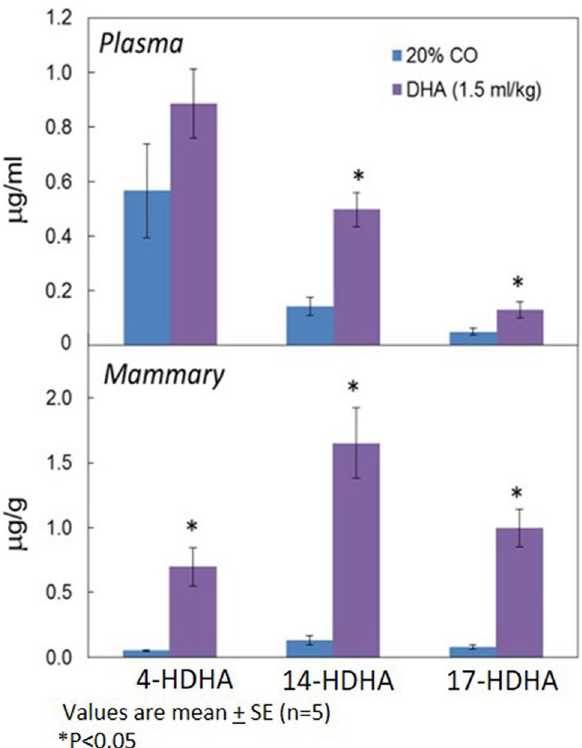
Figure 1. Levels of 4-HDHA, 14-HDHA, 17-HDHA in plasma and mammary tissues of rats treated with DHA using LC–MS/MS